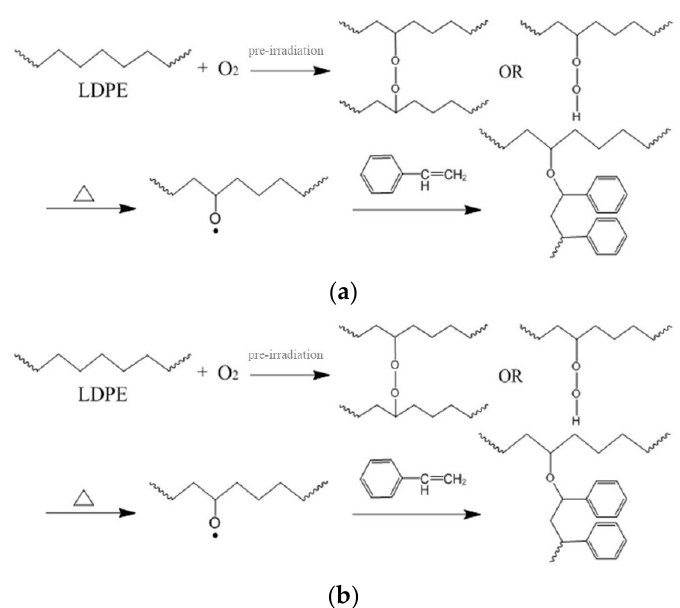
Figure 1. The reaction processes in the production of low-density polyethylene-g-polystyrene (LDPE-g-PS): ( a ) macromolecular free radical initiation and ( b ) benzoyl peroxide (BPO) initiation.